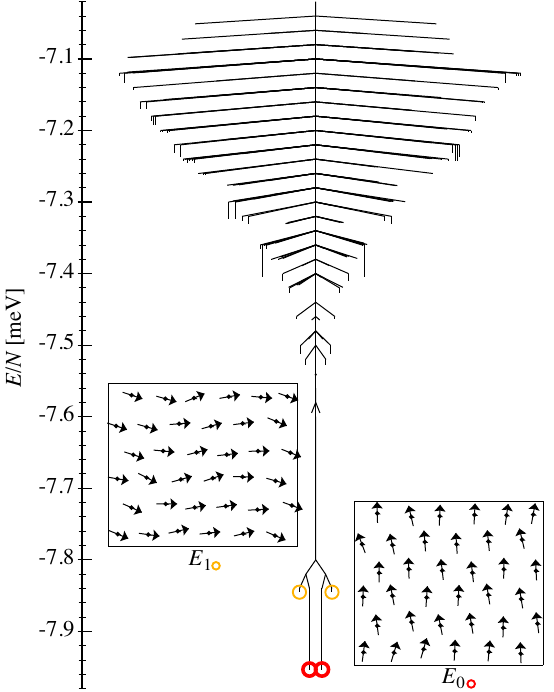
FIG. 6. Disconnectivity graph of the weakly disordered, triangular-lattice ensemble illustrated in Fig. 1(b). As in the square lattice (Fig. 5), the doubly degenerate global minima (red circles) and hubs (orange circles) can be clearly distinguished from the remaining higher-lying local minima, which show particularly small energy barriers towards the ground states. The insets illustrate the magnetic configuration at a global minimum ( E 0 ) and its closest hub ( E 1 ). See also Fig. 3